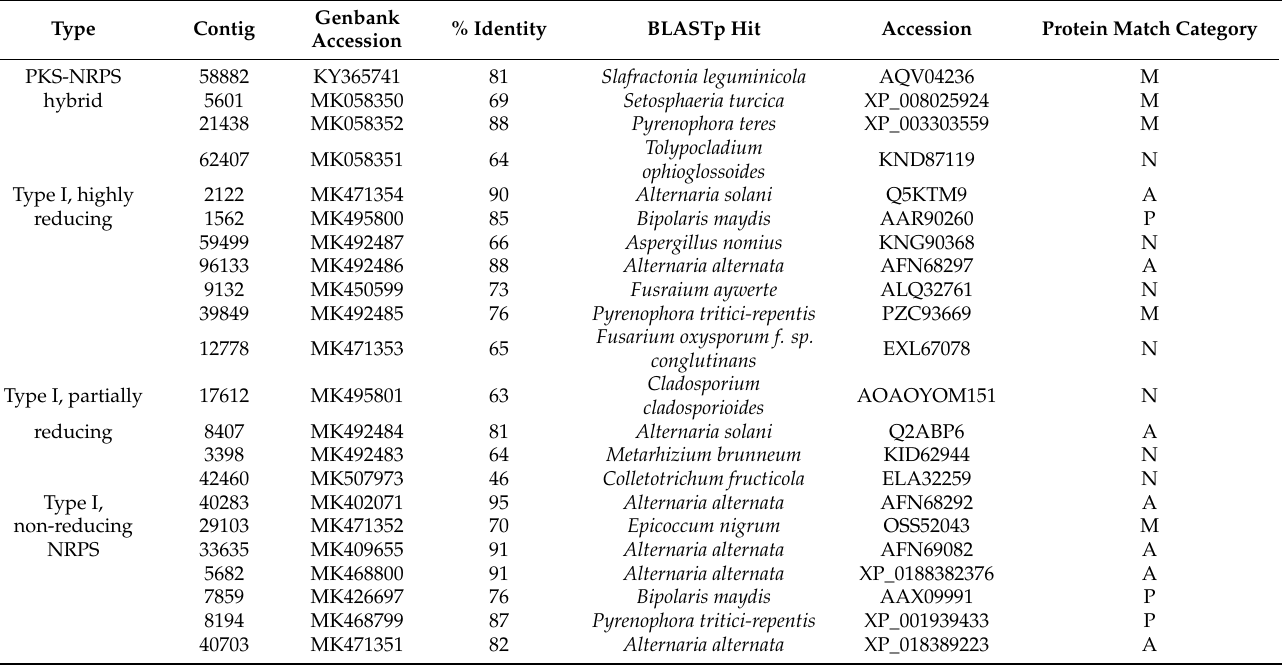
% query cover (percentage of the protein that was included in the match) averaged 99.1% (range 97–100); A = Alternaria genus 1–4 >Pleospo- racae family; P = Pleosporaceae family 1–4; M = Pleosporales order 1–2 > not Dothidiomycetes class; N = not Pleosporales order/not Dothidiomycetes